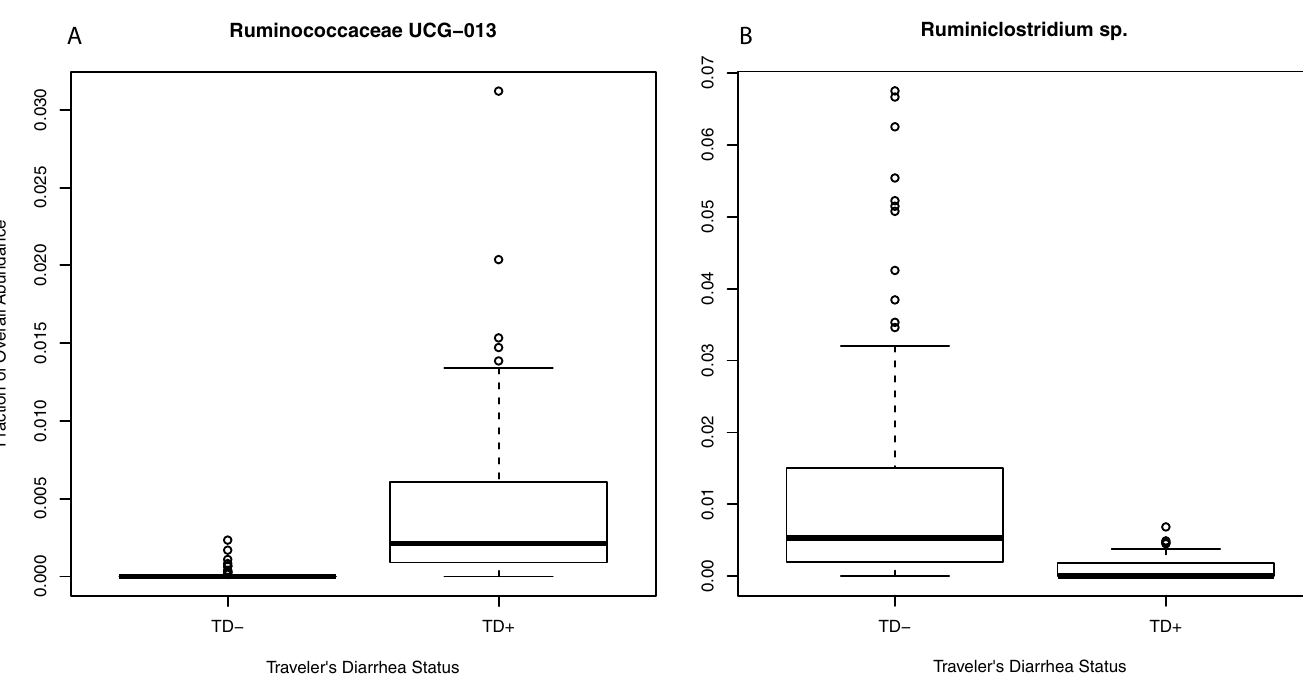
Fig 5. SVs differentially abundant based upon traveler’s diarrhea status. Two SVs showed differential abundance with a linear mixed model approach and after FDR correction for TD+ vs TD- subjects. The relative abundance of each are shown, separated by subjects who experienced TD versus those who did not (specific time points of TD incidents are not included). The most specific taxonomic classification for the sequence variant is shown; Ruminococcaceae UCG-013 in A (p-value 0.0053), and a Ruminiclostridium spp. in B (p-value 0.040). The p-values are FDR corrected.